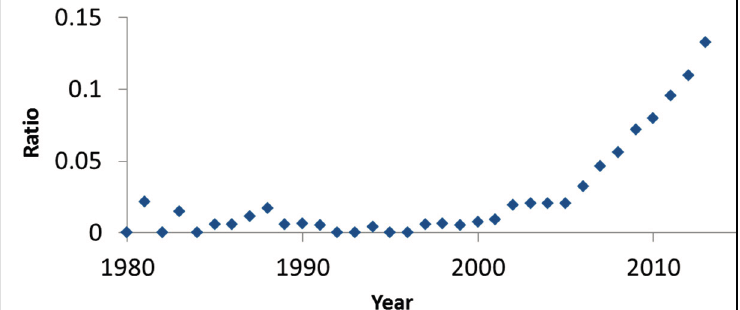
Figure 3. The ratio between the number of SciFinder™ hits for “rhodamine B” + “visible light” + “photocatalysis” and the number of hits for “visible light” +